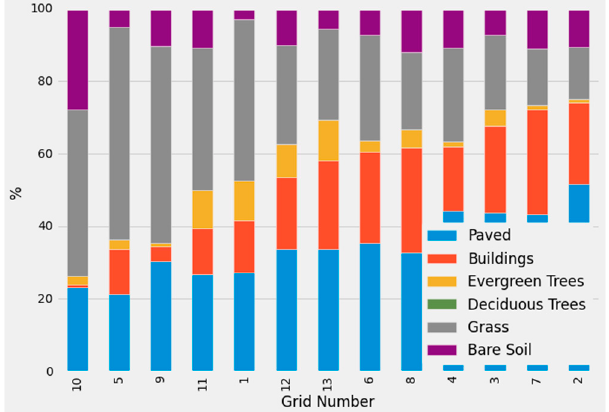
Figure 9. Current land cover percentages per grid cell shown in ascending order of impervious cover (Buildings + Paved) percentage.